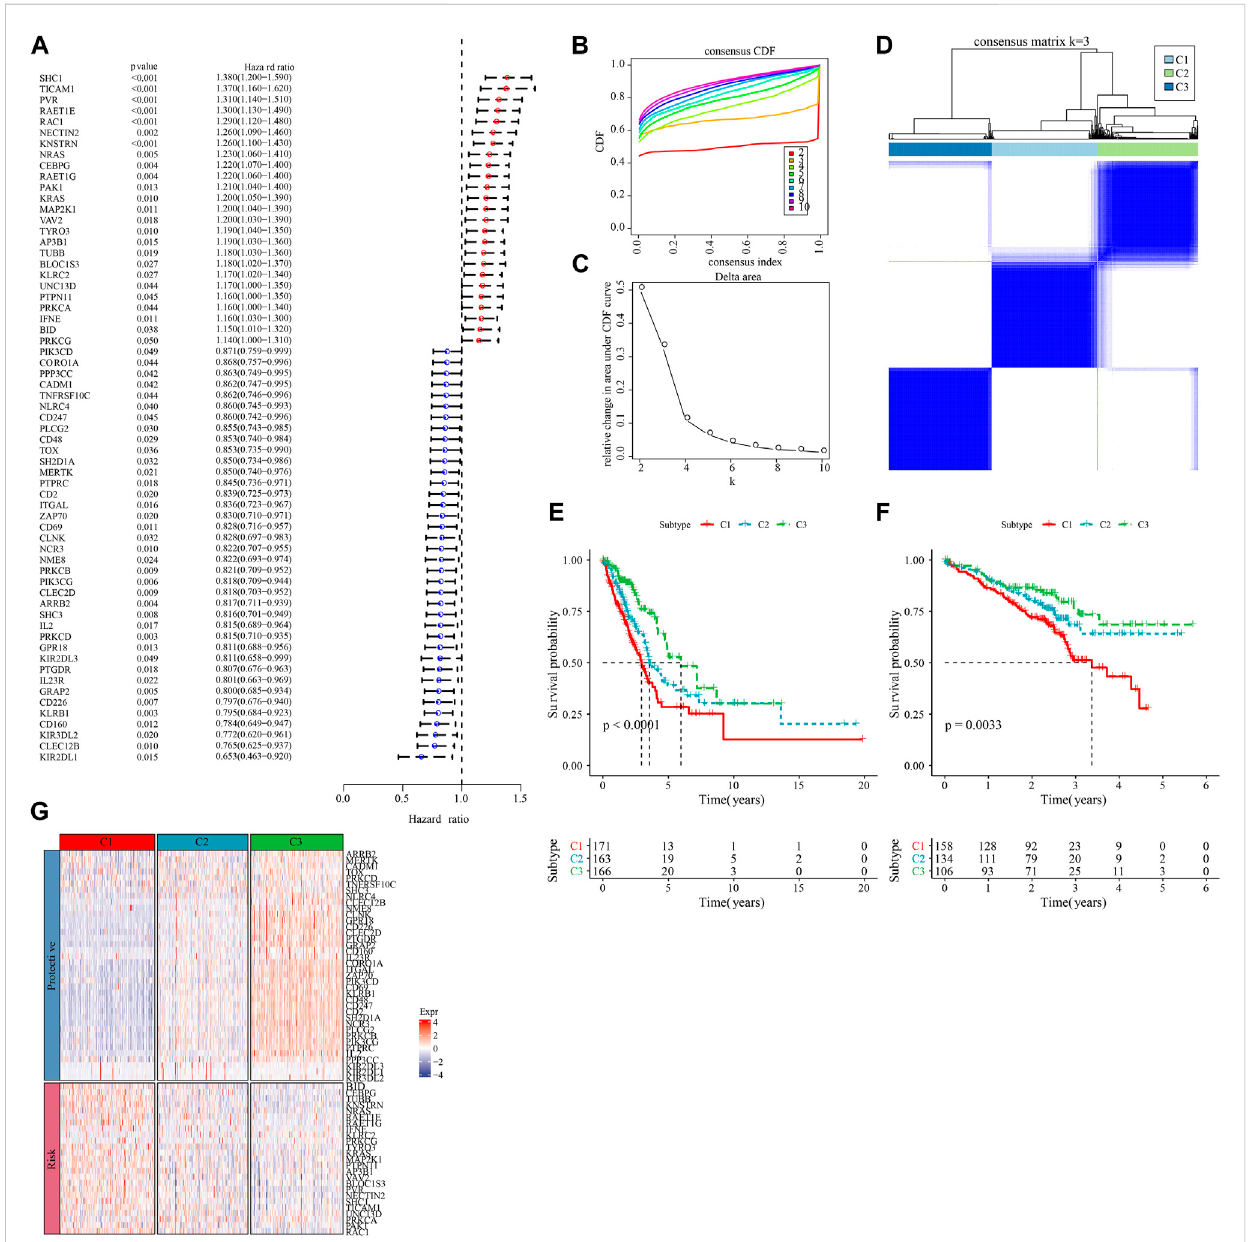
FIGURE 1 Molecular subtyping based on natural killer cell-associated genes. (A) Forest plot of prognostically signi fi cant natural killer cell-associated genes in the TCGA-LUAD cohort. (B) CDF curves of the TCGA-LUAD cohort. (C) CDF Delta area curves of the TCGA-LUAD cohort. (D) heat map of sample clustering atconsensus k =3intheTCGA-LUAD cohort. (E) KMcurvesoftherelationshipbetweenoverallsurvival(OS)prognosisofthethreesubtypesin the TCGA-LUAD cohort. (F) Prognostic differences between the three molecular subtypes in the GSE72094 cohort. (G) Heatmap of prognosis signi fi cant natural killer cell genes expression in different subtypes of